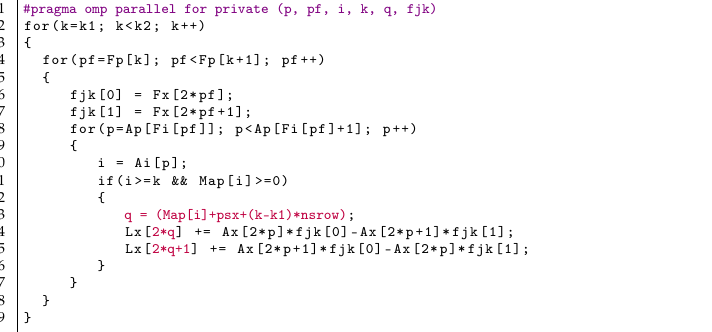
Figure 7. Loop to parallelize in the subroutine cholmod _ super _ numeric from the supernodal module in CHOLMOD from the SuiteSparse benchmark suite [20]. The outermost k –loop can be parallelized if array Map has values in the range [ 0 : nsrow 1 ] . −